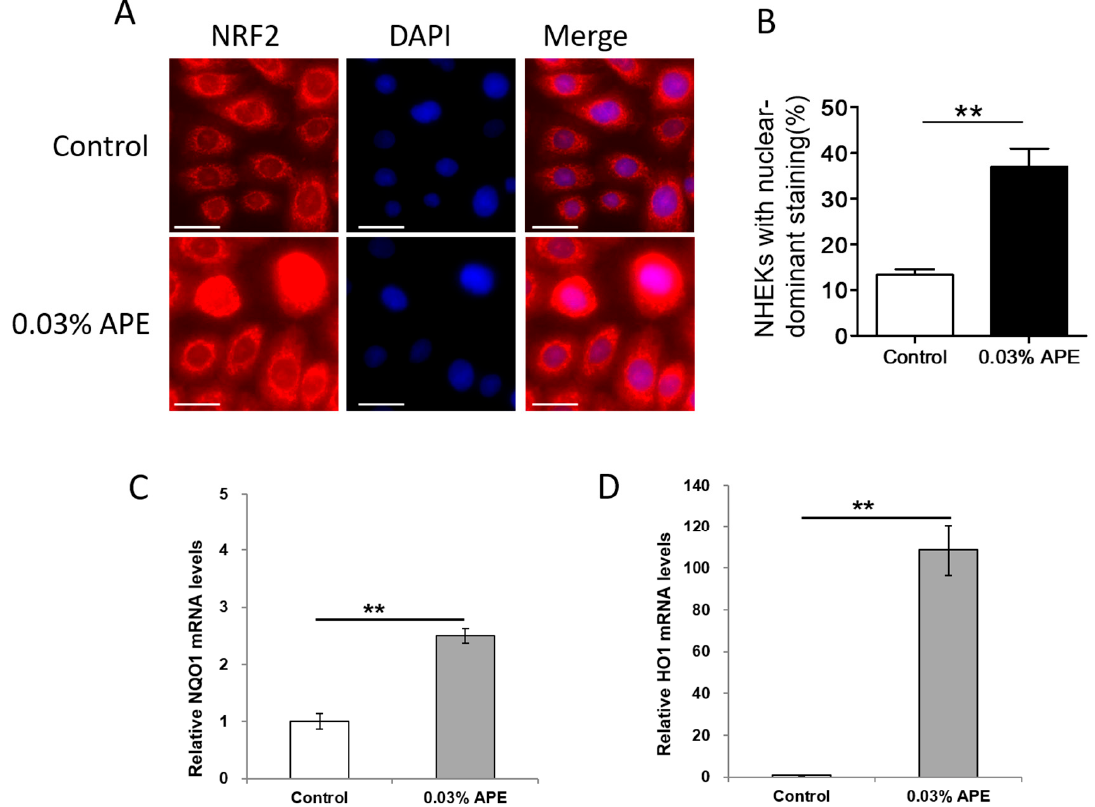
Figure 1. ( A ) Localization of NRF2 is visualized by an immunofluorescence technique. NRF2 is mainly located in the cytoplasm of control keratinocytes. Nuclear staining of NRF2 is enhanced in the keratinocytes treated with APE for 6 h. Nuclei are stained with 4 ′ ,6-diamidino-2-phenylindole (DAPI). Scale bar, 20 µ m; ( B ) the number of NHEKs with nuclear-predominant staining of NRF2 is significantly increased by APE treatment than that of control; ( C ) APE upregulates the gene expression of antioxidant enzyme NQO1 ; and ( D ) APE also upregulates the gene expression of antioxidant enzyme HO1 . ** p < 0.01.